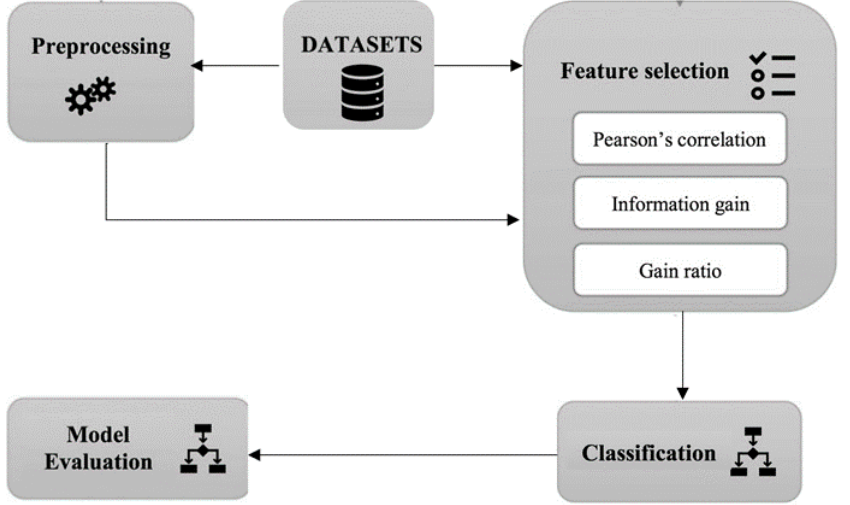
Figure 1. The workflow of this study .